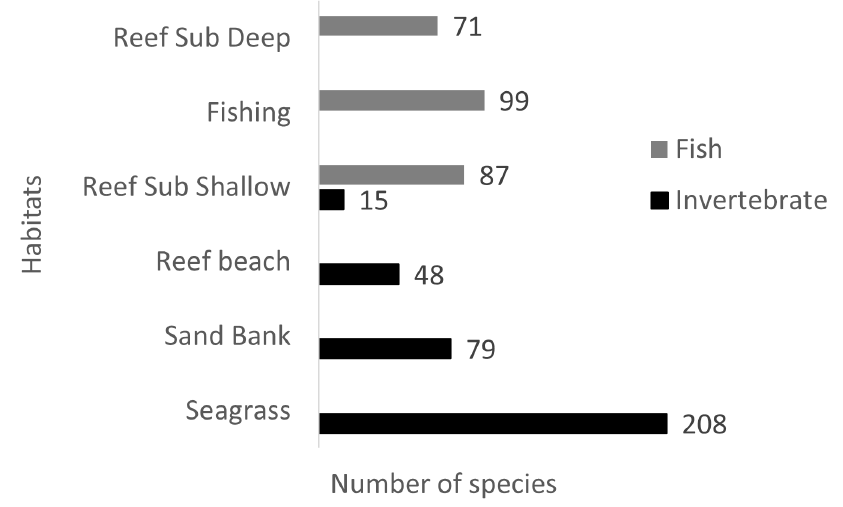
Figure 2. Total number of species of invertebrates and fishes at each habitat on the eastern coast of